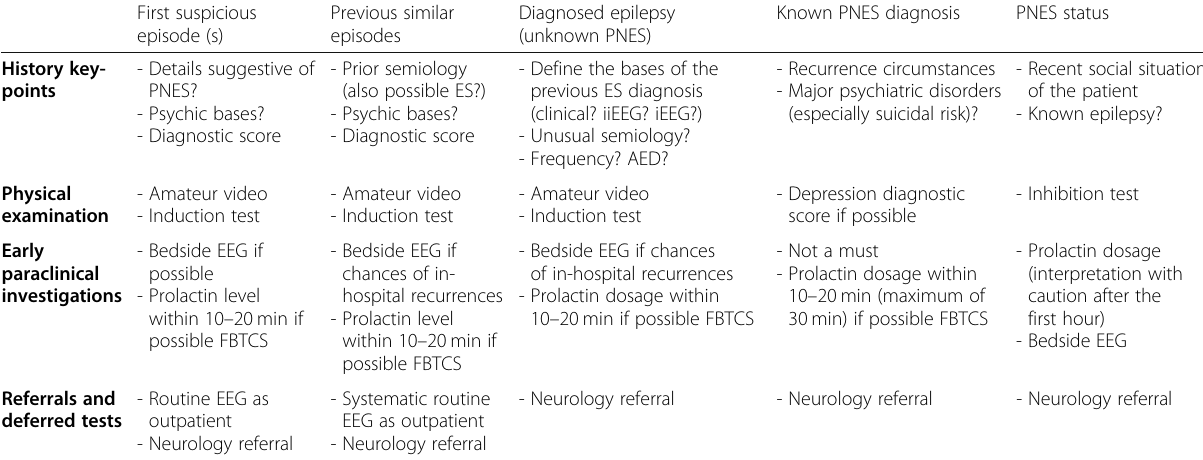
Table 3 Key-points of practical management (positive and severity diagnoses) according to the